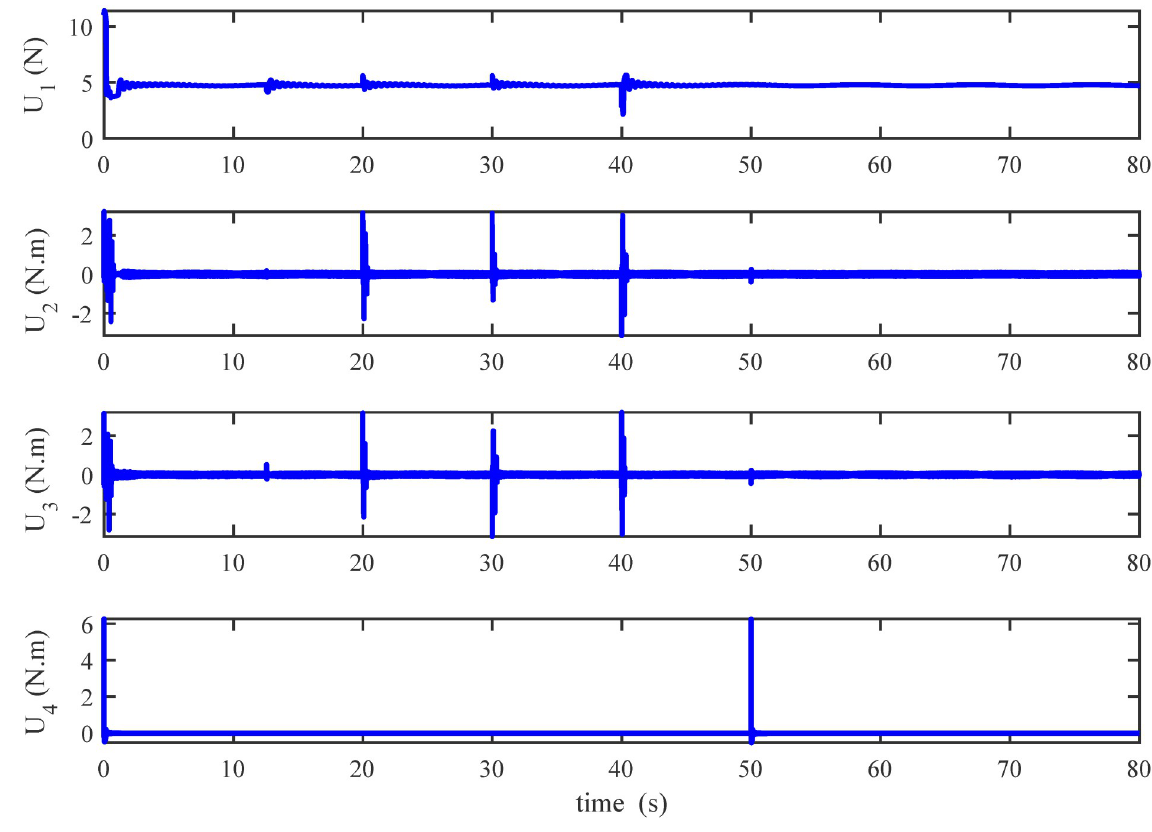
Fig 9. Results of the inputs under the proposed controller.